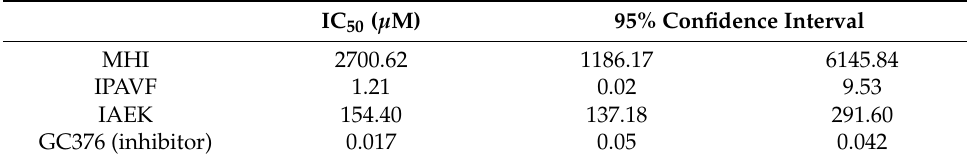
Table 2. Experimental IC 50 values for the inhibition of SARS-CoV-2 3CL pro .